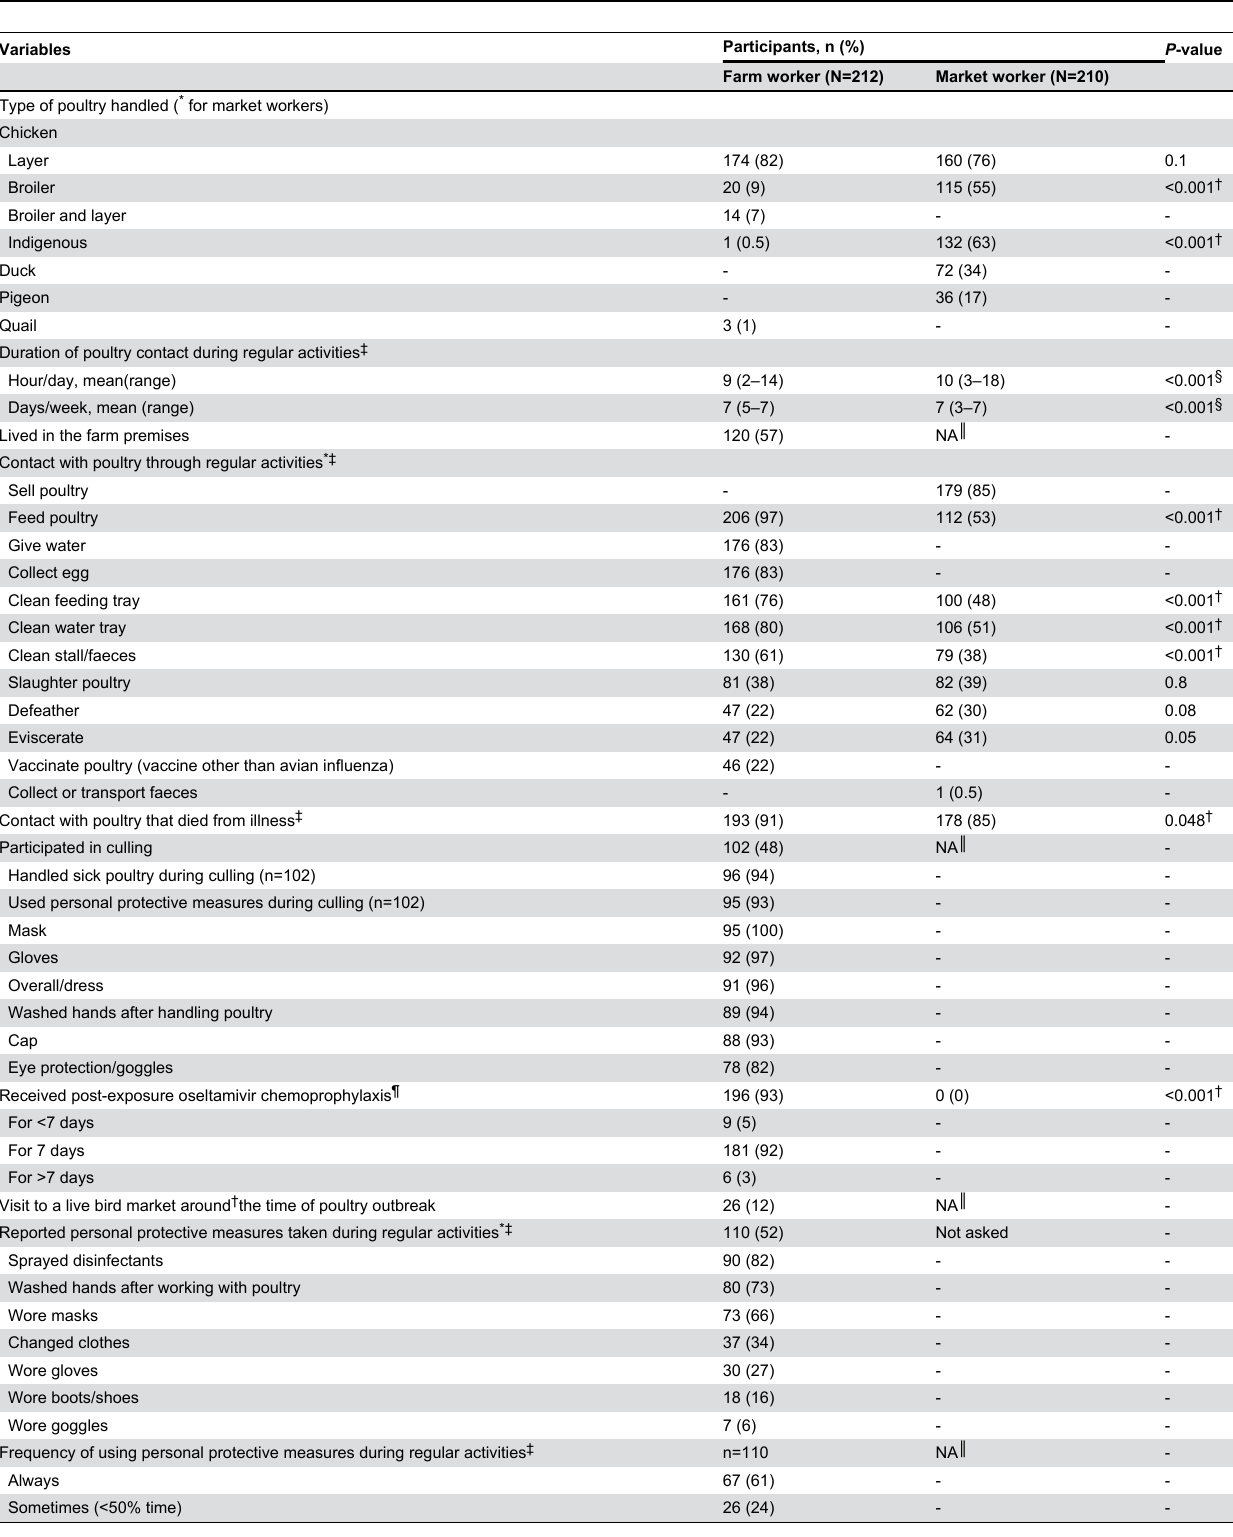
Table 2. Reported occupational exposure to confirmed or suspected HPAI H5N1 virus-infected poultry, use of personal protective measures and respiratory illness among farm and market workers,